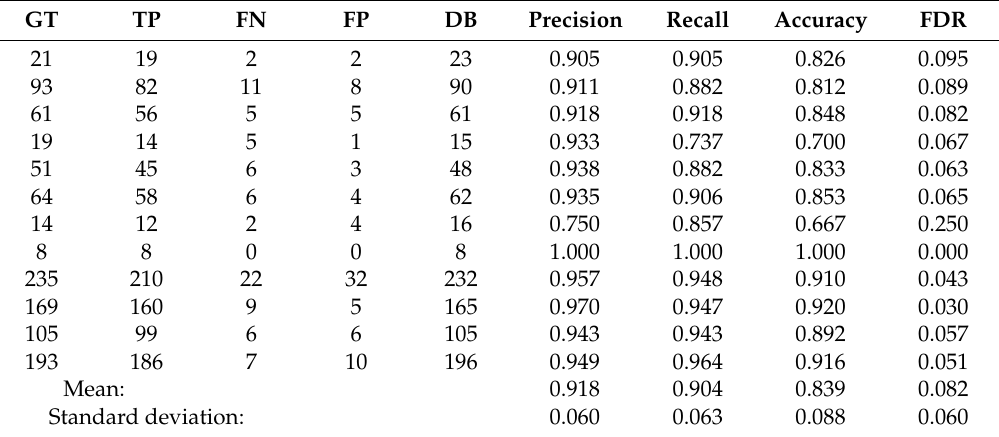
Table 6. The performance evaluation of the proposed